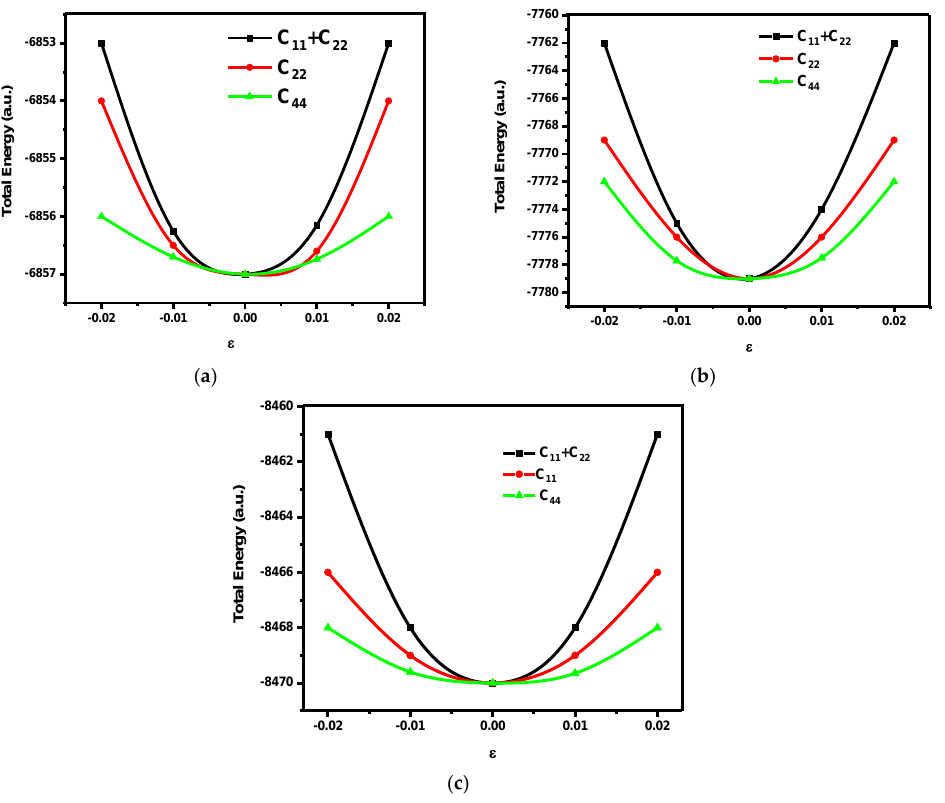
Figure A7. Energy variations due to application of strains (deformation) and its influence on the elastic constants C 44 , C 11 & C 11 + C 22 for ( a ) AlCoCuFeNi ( b ) AlCoCrFeNi and ( c ) AlCoCrFeNiTi.